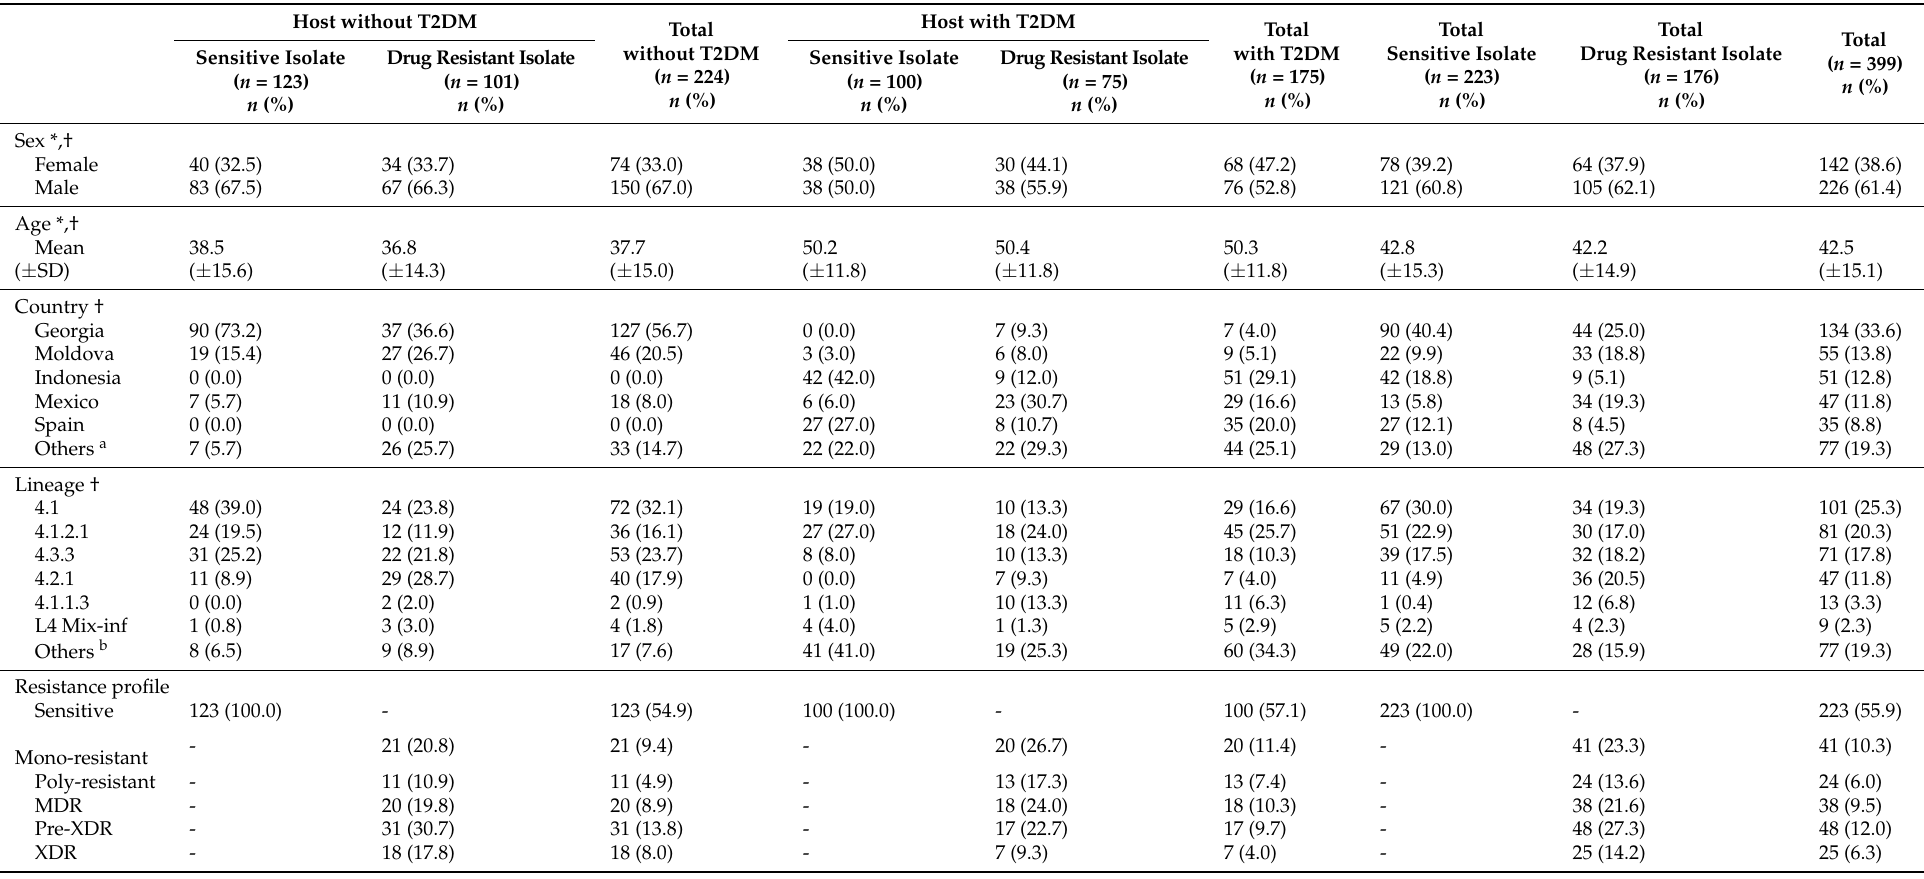
Table 1. Sociodemographic and epidemiological characteristics of the individuals comprising the group of